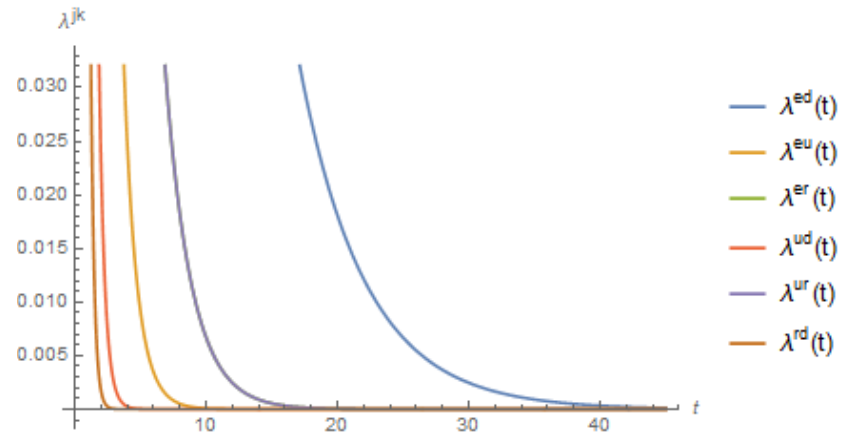
Figure 3. Six decrement probabilities under jump-diffusion process as a function of time t .